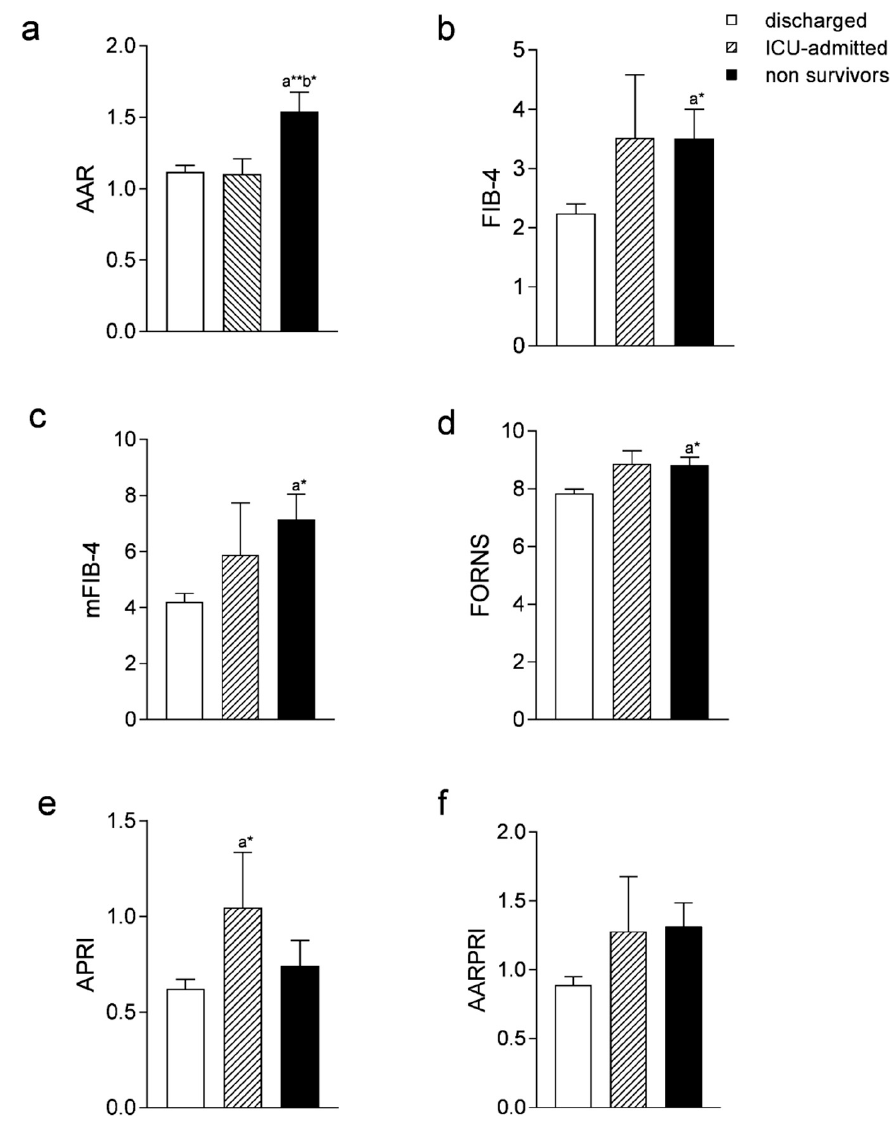
Figure 2. Comparison of Liver Fibrosis Scores among discharged, admitted to Intensive Care Unit (ICU), and non-survivor patients. Comparison of AAR ( a ), FIB-4 ( b ), mFIB-4 ( c ), FORNS ( d ), APRI ( e ), AARPRI ( f ) scores among discharged, ICU-admitted, and non survivor patients. Data are presented as mean ± SEM. Comparisons were performed using one-way ANOVA test followed by Bonferroni’s post hoc test. Multiple comparison was performed by Student t -test. Lowercase letter in the subfigures indicates significant difference (* p < 0.05, ** p < 0.001) between two groups: ( a ) for discharged patients, ( b ) for ICU admitted patients. Abbreviations: AST to ALT ratio: AAR; fibrosis-4 index: FIB-4; modified FIB-4: mFIB-4; AST to Platelet Ratio Index: APRI; AAR to Platelet ratio: AARPRI.